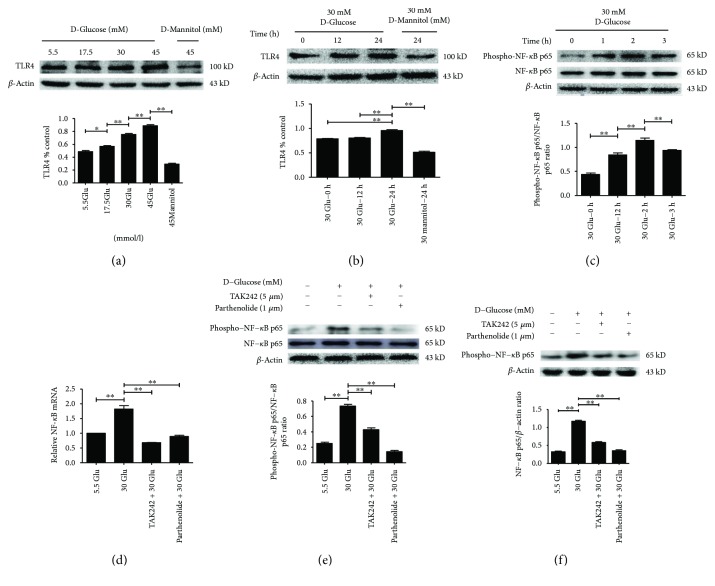
HG increased TLR4 expression and activated NF-κB p65 phosphorylation in HK-2 cells. a–b: Protein levels of TLR4 in HK-2 cells following exposure to D-glucose (5.5 mM, 17.5 mM, 30 mM, and 45 mM) for 24 h (a) or D-glucose (30 mmol/L) for various times (0 h, 12 h, and 24 h) (b), and expression of NF-κB p65 and phospho-NF-κB p65 of cells exposed to 30 mM HG for indicated time points (0 h, 1 h, 2 h, and 3 h) (c) were determined by Western blot analysis. d–f: HK-2 cells were treated with TLR4 inhibitor (TAK242, 5 μM) for 2 h prior to HG (30 mM) treatment for 2 h (e) or 24 h (f) and with NF-κB blocker (parthenolide, 10 μM) and HG (30 mM) for 2 h (e) or 24 h (f), and the samples were collected for RT-PCR (d) and Western blot analysis (e–f). Each assay was representative of three independent experiments. Data were expressed as means ± SEM; ∗P < 0.05 and ∗∗P < 0.01.